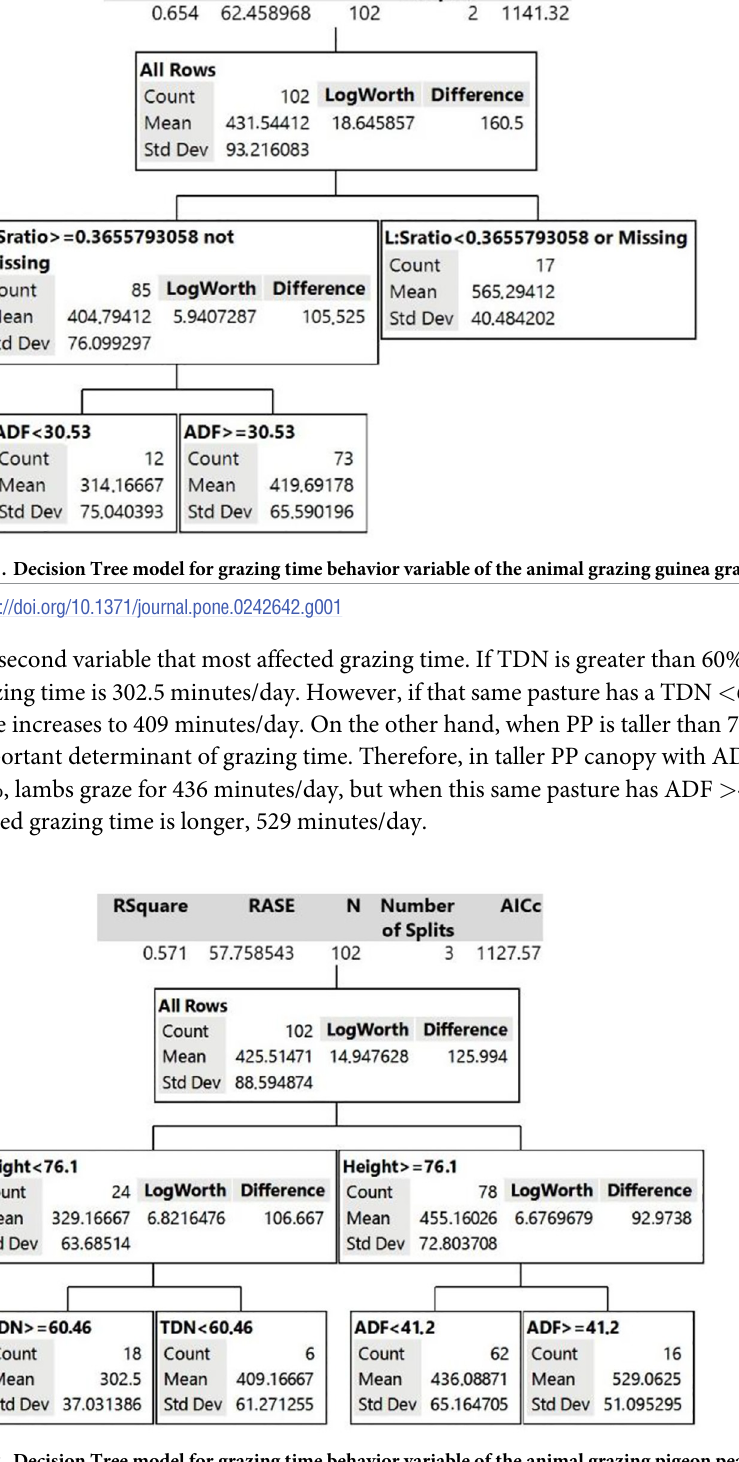
Fig 2. Decision Tree model for grazing time behavior variable of the animal grazing pigeon pea legume (PP